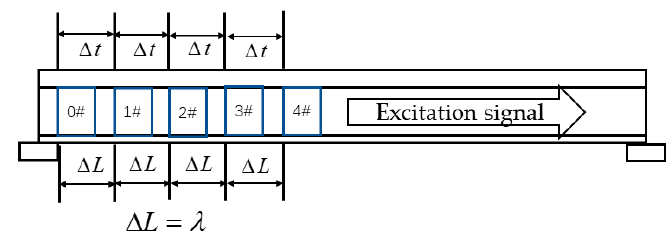
Figure 10. Phased array excitation diagram.